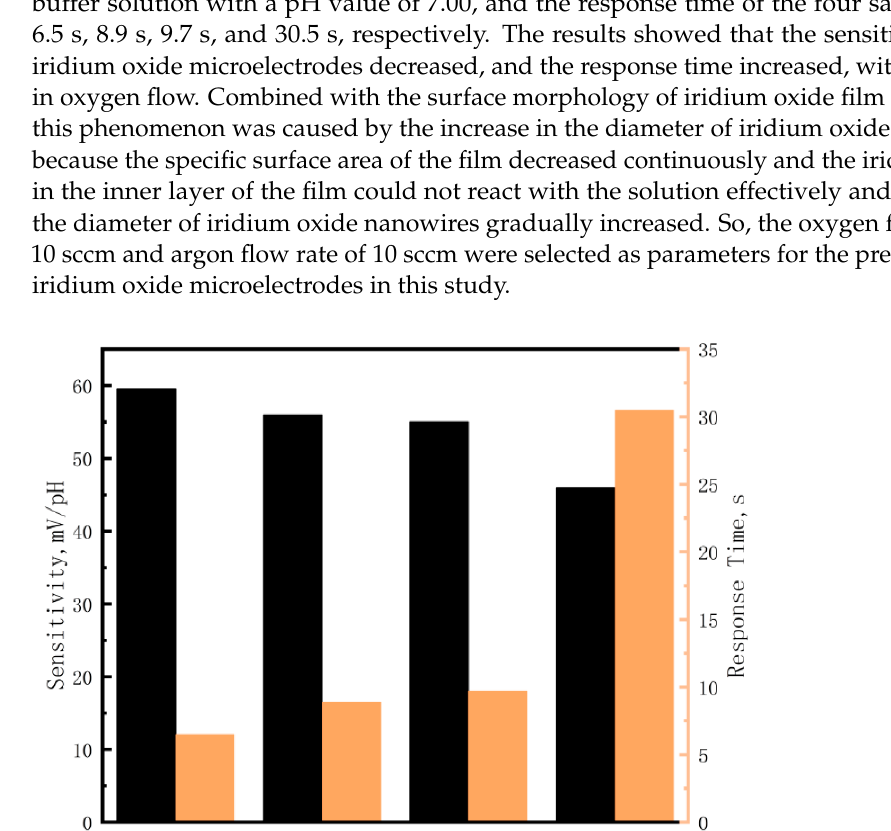
Figure 5. The sensitivity and response time of iridium oxide films prepared at oxygen flow rates of ( a ) S1 10 sccm, ( b ) S2 20 sccm, ( c ) S3 30 sccm, and ( d ) S4 40 sccm; the Ar flow rate was maintained at 10 sccm during the sputtering process.